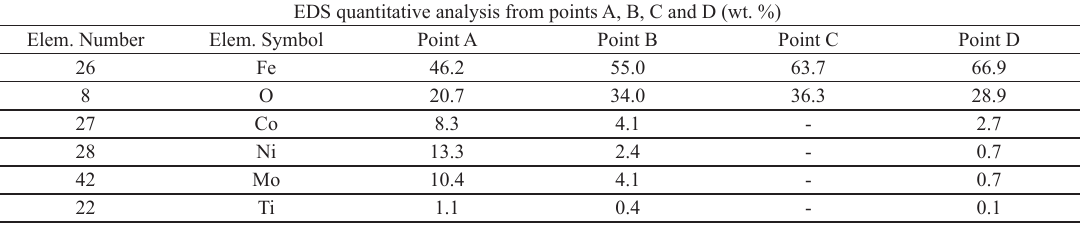
Table 6. Summary of the chemical composition determined by EDS measurements taken at the different positions indicated in Figure 9c. EDS quantitative analysis from points A, B, C and D (wt. %)